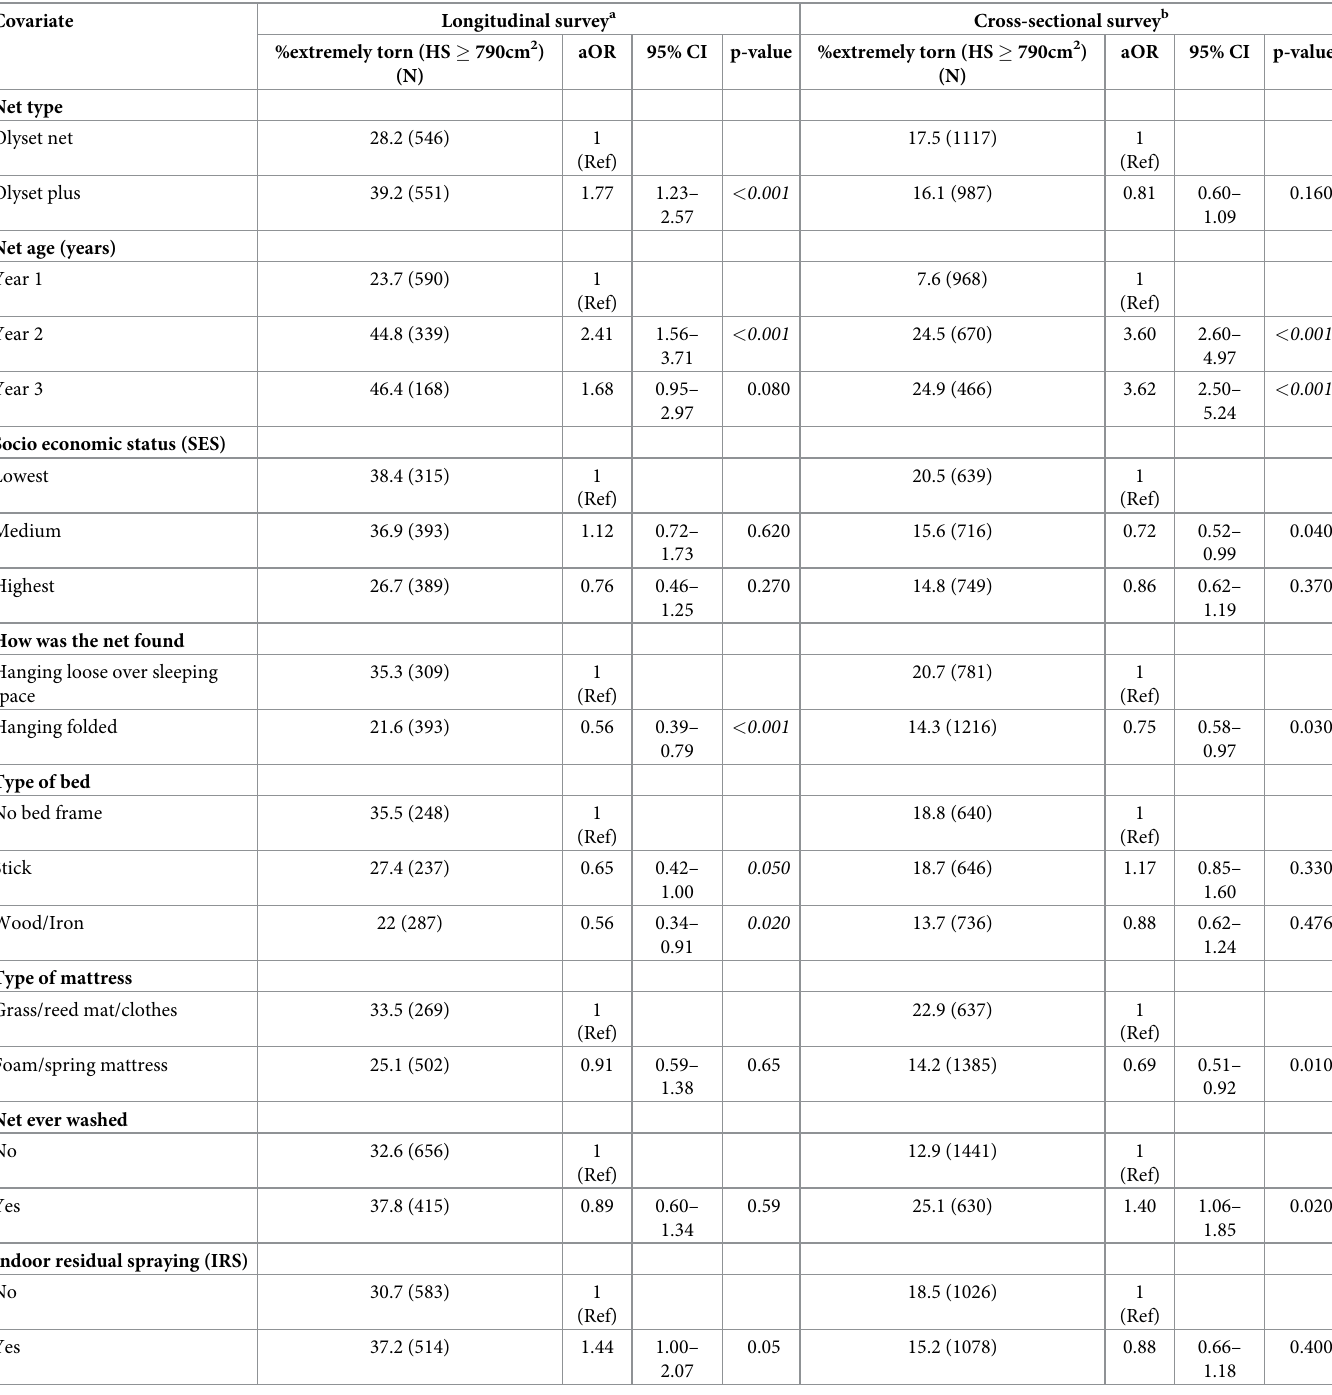
Table 5. Factors associated with LLIN being classed as unserviceable (HS: � 790cm 2 ) (data from longitudinal and cross-sectional